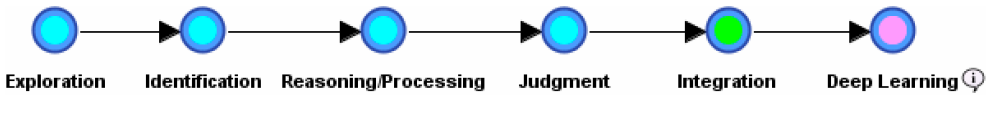
Figure 1. Sensemaking process model for deep learning